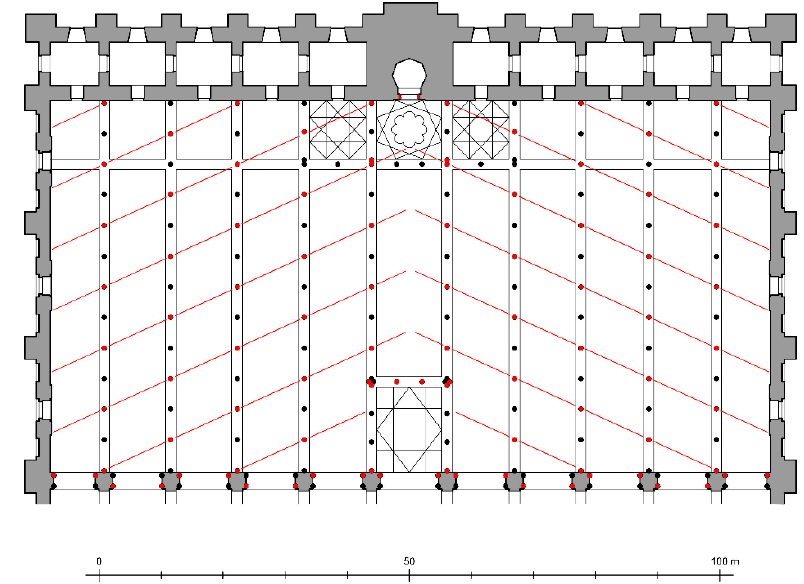
Figure 6. Reconstructed ground plan of the extension of the mosque of Córdoba executed by al- Ḥ akam II in 961–971, with distribution of column shafts in reddish-pink breccia (indicated in red) and in dark gray limestone (indicated in black). Drawing by Felix Arnold, based on the plan of Christian Ewert.